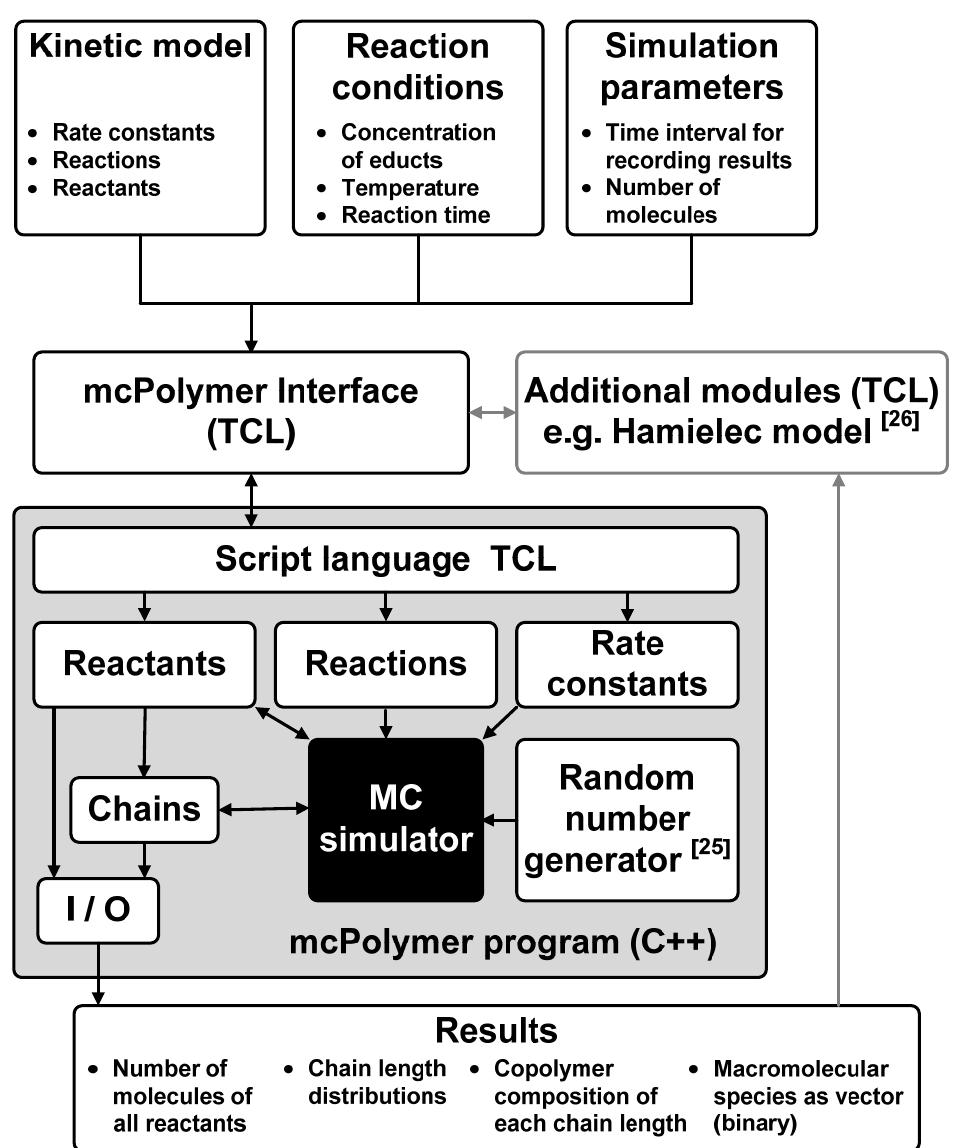
Figure 1. Software architecture of the mcPolymer